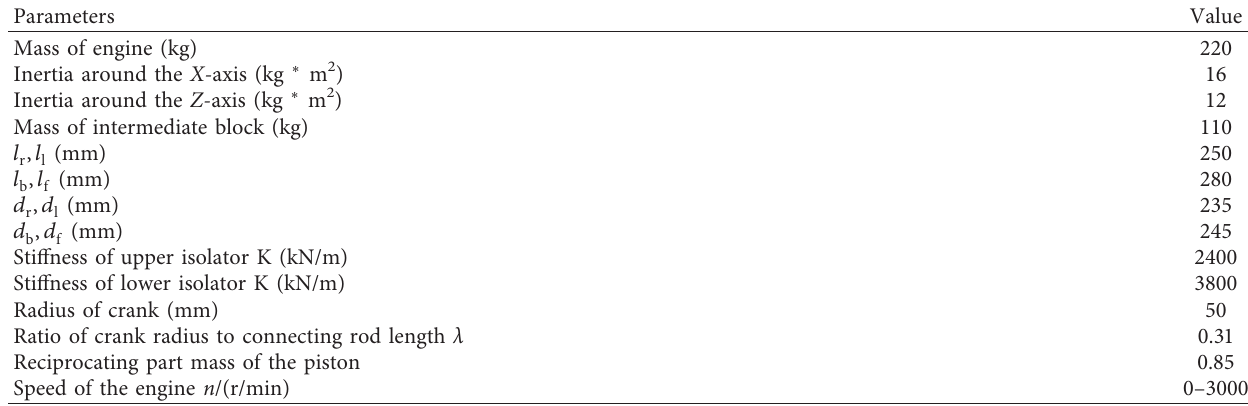
Table 2: Simulation parameters of the two-stage isolation